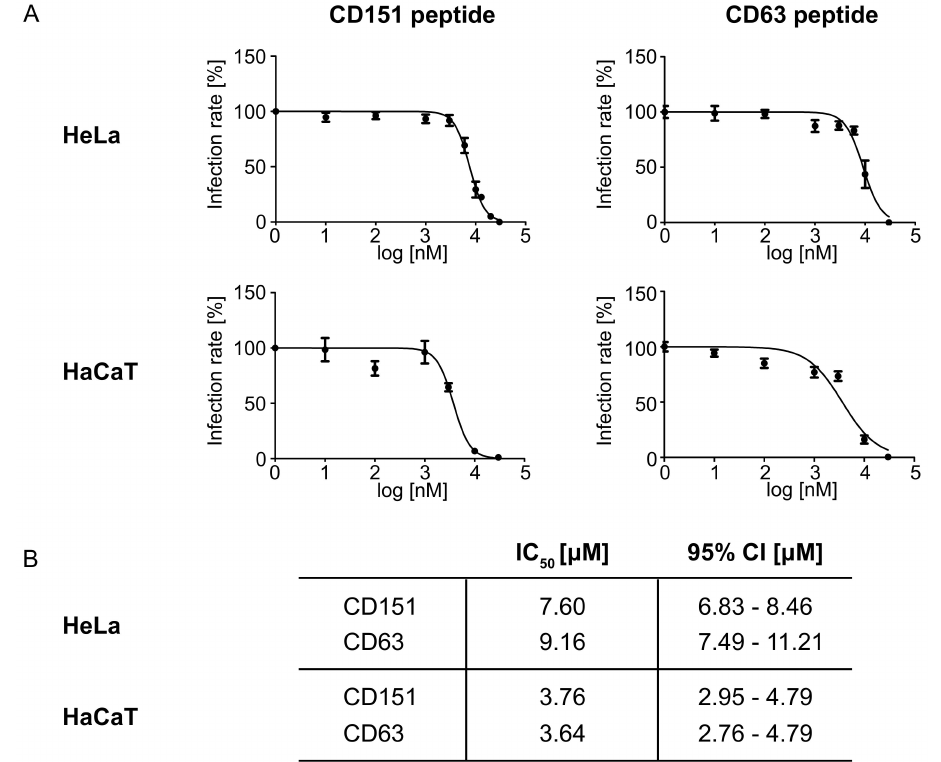
Figure 4. Dose-response curves ( A ) and IC 50 with 95% CI values ( B ) of C-terminal peptides of CD63 and CD151 in HPV16 infection. Cells were incubated with C-terminal peptides at final concentrations ranging from 1 to 30,000 nM for 1 h. Afterwards, the cells were infected with HPV16 PsVs. Pseudovirus infection assays were performed 24 h after PsVs addition. The data is shown as mean ± SEM. 2.4. Blocking Peptides of the Cytoplasmic C-Terminal Tail of Tetraspanins Inhibit Human